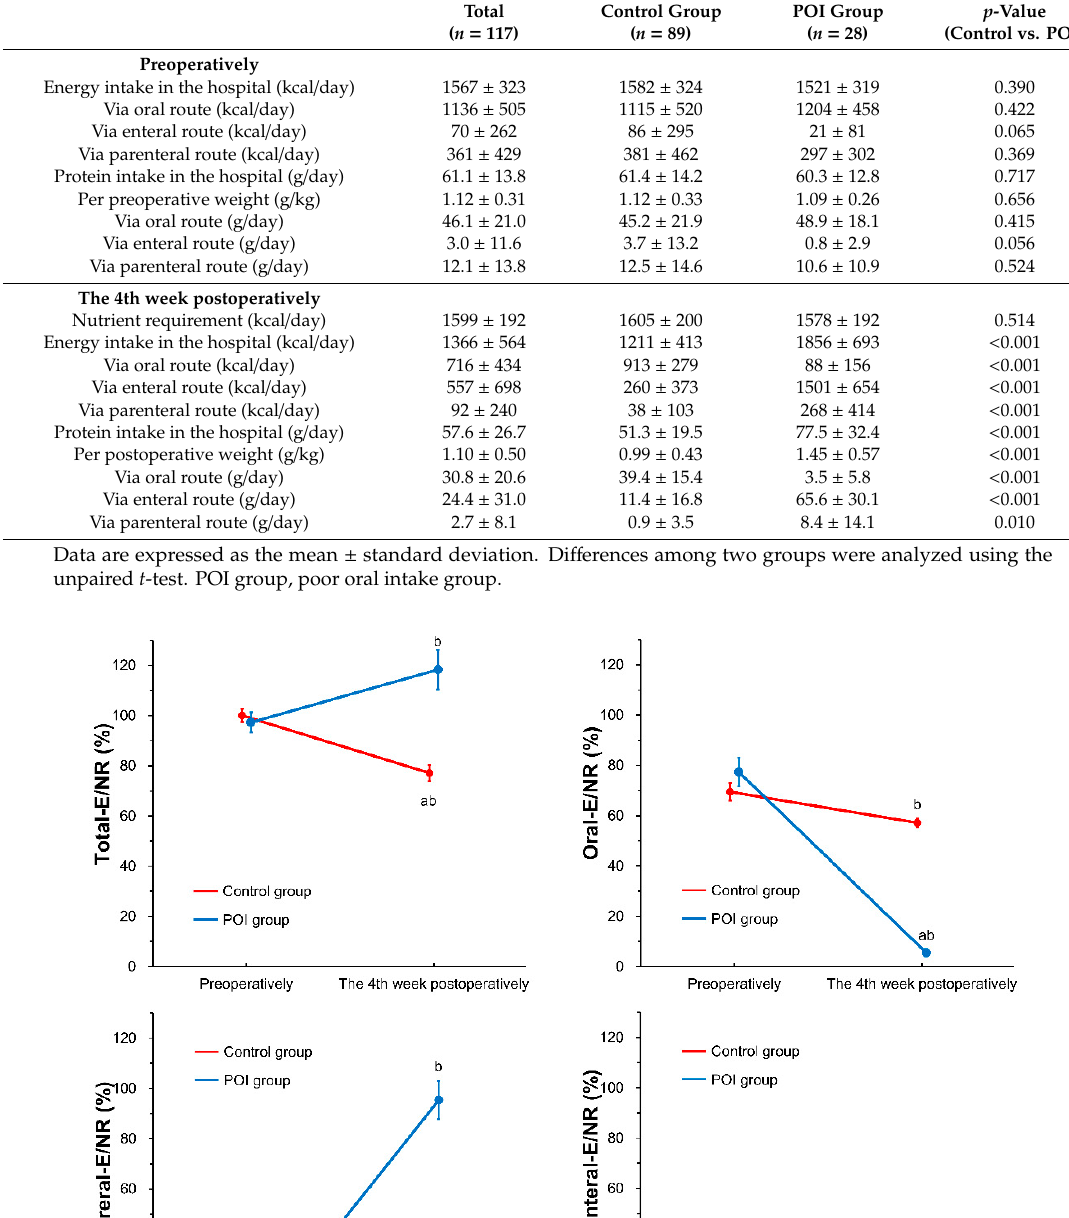
Table 2. Comparison of nutrient intake in the hospital between the study groups.